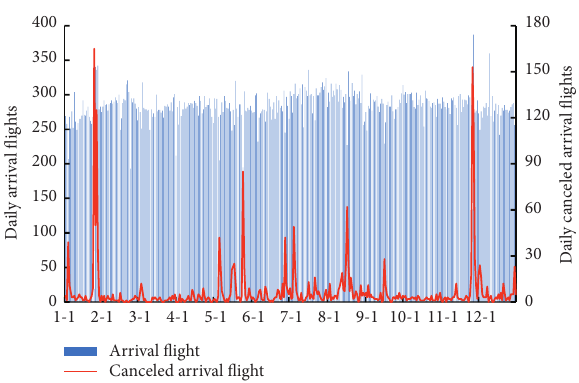
Figure 1: Daily arrival flights and canceled flights in Table 1: Partial data of the real-time meteorological indicators.